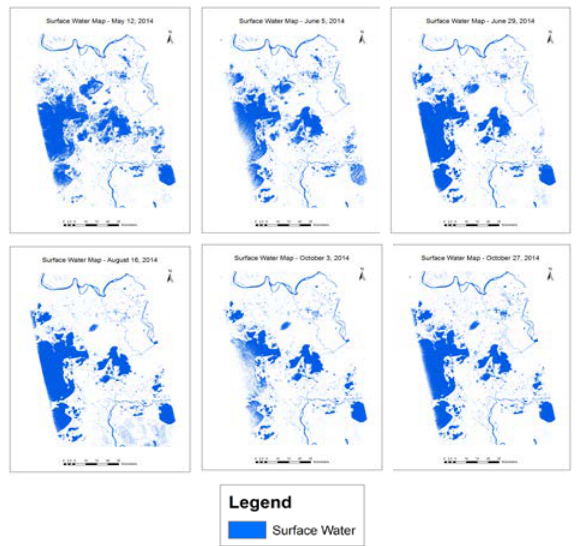
Figure 4. Example surface water product from the PAD for 2014.